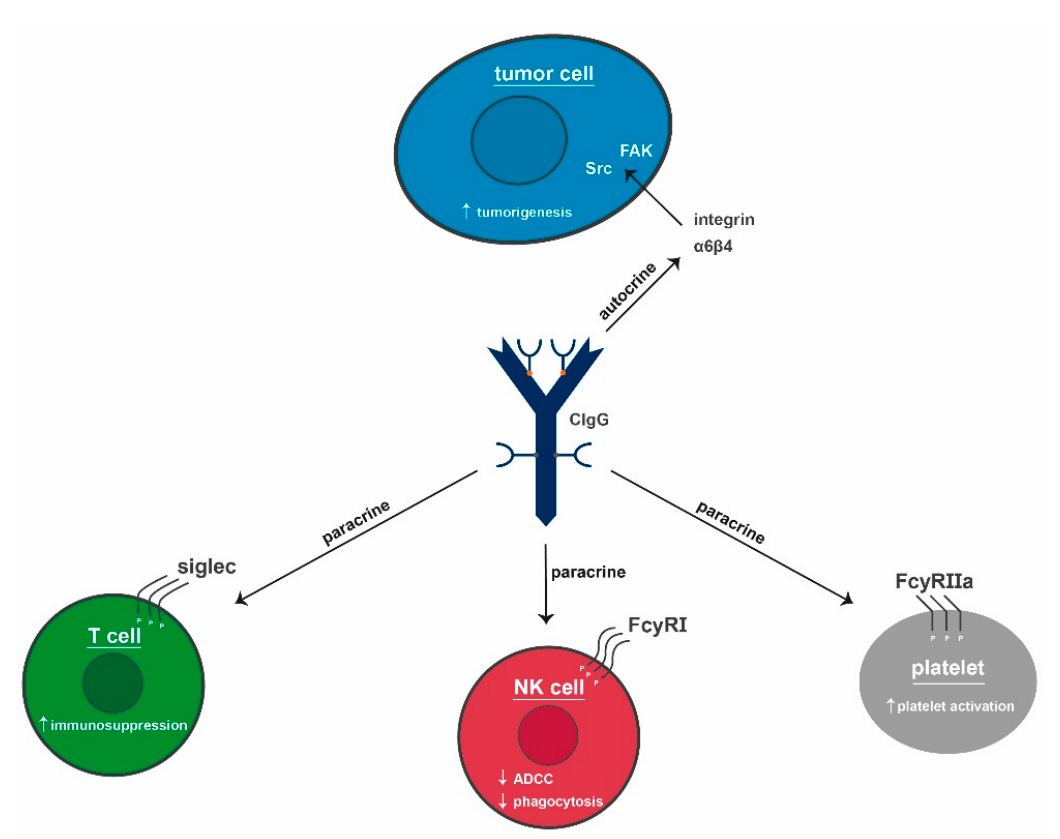
Figure 5. CIgG (blue) and its putative mode of action. CIgG is secreted by tumor cells and functions as an activator of integrin α 6 β 4 on tumor cells (autocrine), siglecs on T cells, Fc γ RI on NK cells, and Fc γ RIIa on platelets (all paracrine). It drives tumori- genesis, immunosuppression, and platelet activation. Further, it impairs ADCC and phagocytosis. CIgG: cancer-derived IgG, NK cell: natural killer cell, ADCC: antibody-dependent cell-mediated